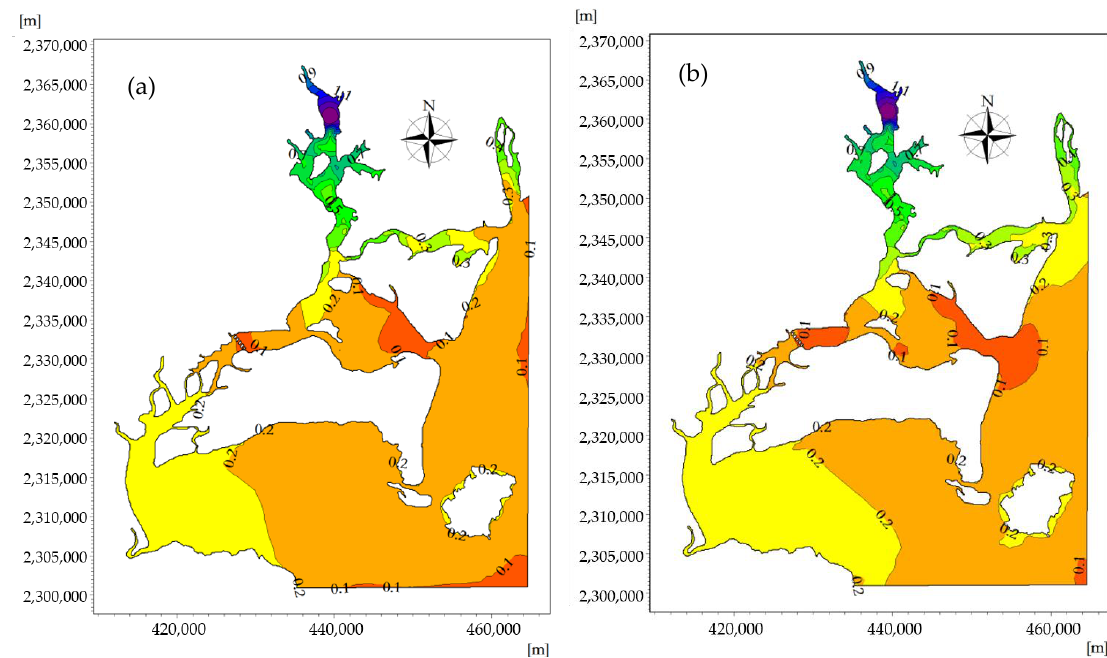
Figure 15. The spatiotemporal distribution of the nitrate concentration across the modeling domain at the moment when the velocity of the flood tide ( a ) and ebb tide ( b ) reaches its maximum (mg/L).